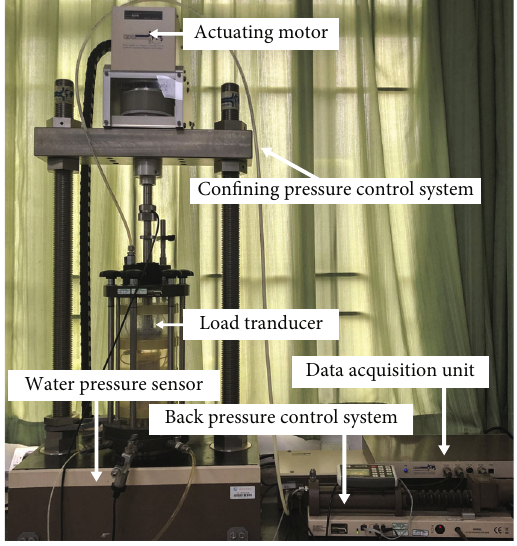
Figure 6: GDS standard dynamic triaxial test system.